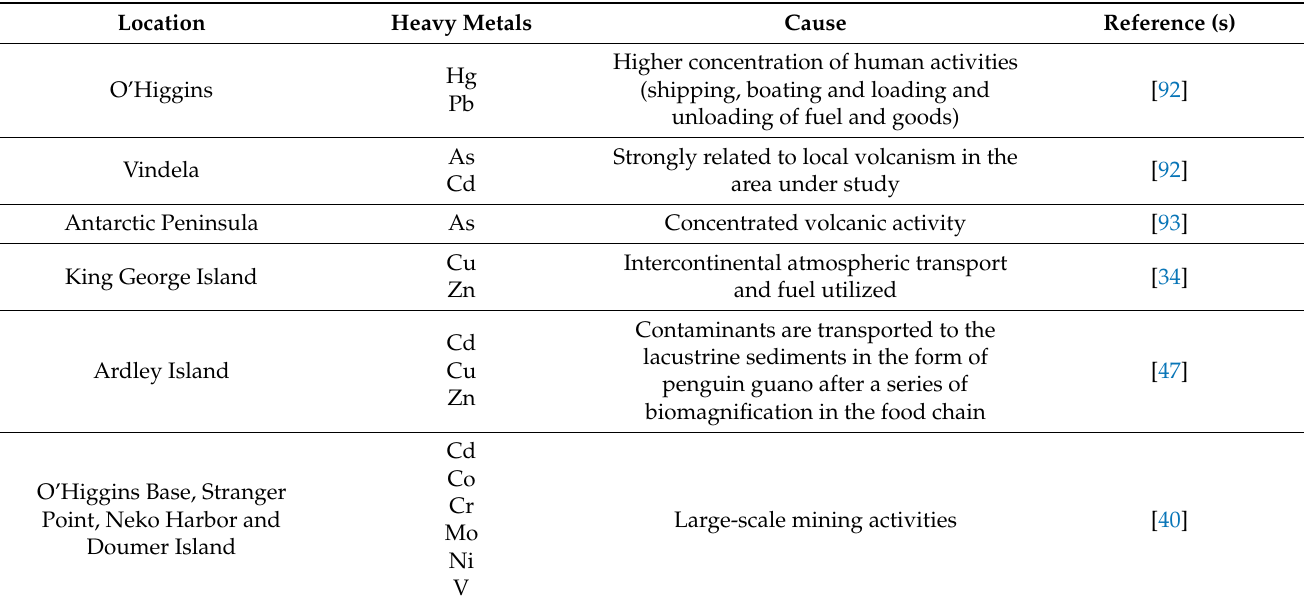
Table 4. Higher concentrations of heavy metals found in